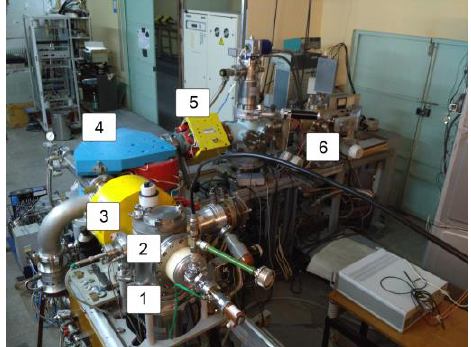
Fig. 3. ECR test bench: 1 - ECR source, 2 - extraction system, 3 - focusing solenoid, 4 - analyzing magnet, 5 - quadrupole lens, 6 - diagnostics block with Faraday cup.